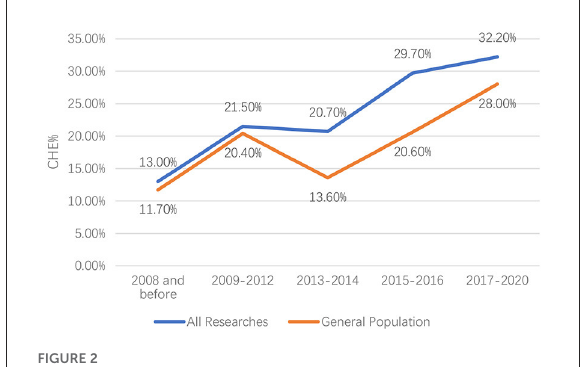
FIGURE2 Secular trend of the rate of catastrophic health expenditures in China 2000 − 2020.